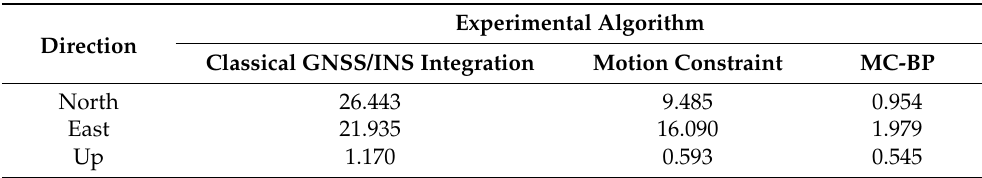
Figure 13. Marine boat experiment’s positioning errors of motion constraint algorithm (Motion Constraint) and MC-BP algorithm: ( a ) north direction; ( b ) east direction; ( c ) up direction. Table 5. RMS values of positioning errors for offshore boat experiment